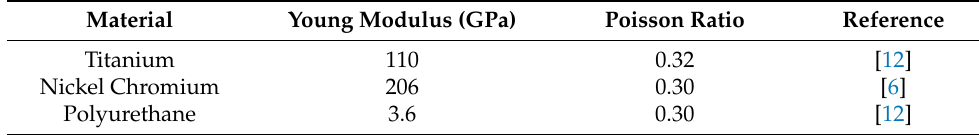
Table 1. Properties of the material used in the